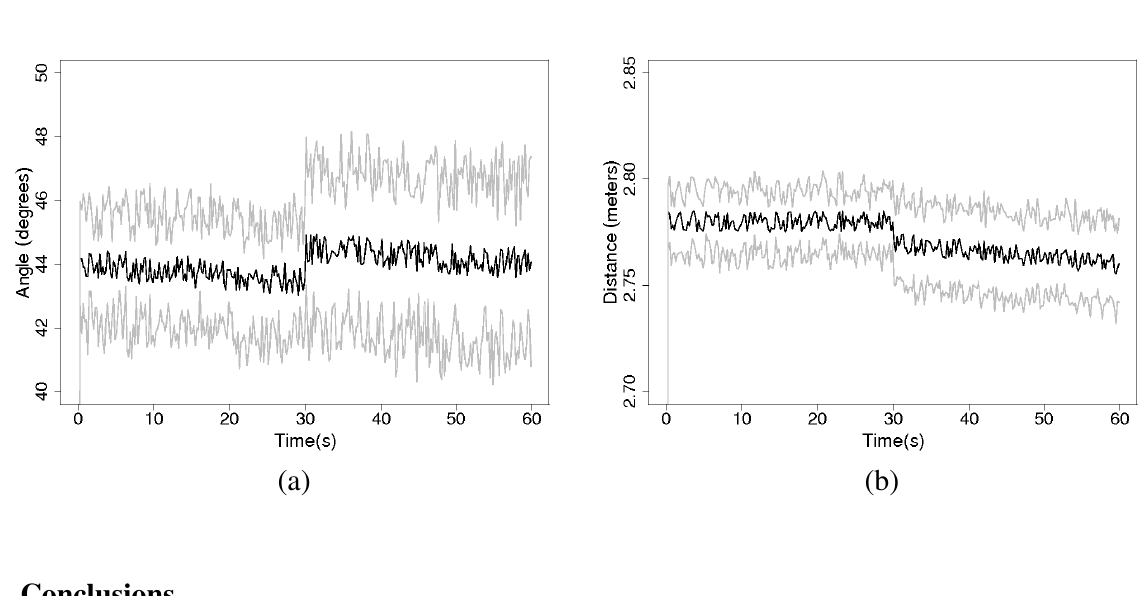
Figure 20. (a) Average bearing estimate (black) and standard deviation (grey) for the multi- node experiment over 30 replications. (b) Average range estimate (black) and standard devi- ation (grey) for the multi-node experiment over 30